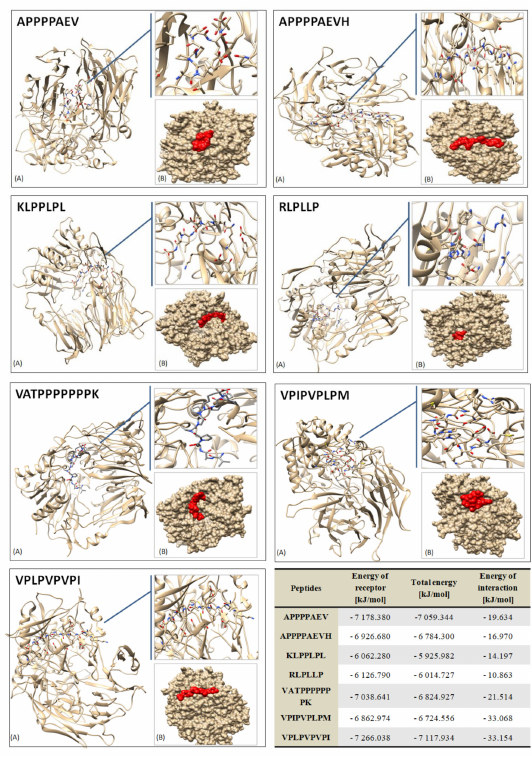
Figure 4. Three-dimensional molecular docking results of the receptor–ligand (peptide) systems in both surface representation ( A ) and cartoon-ribbon representation ( B